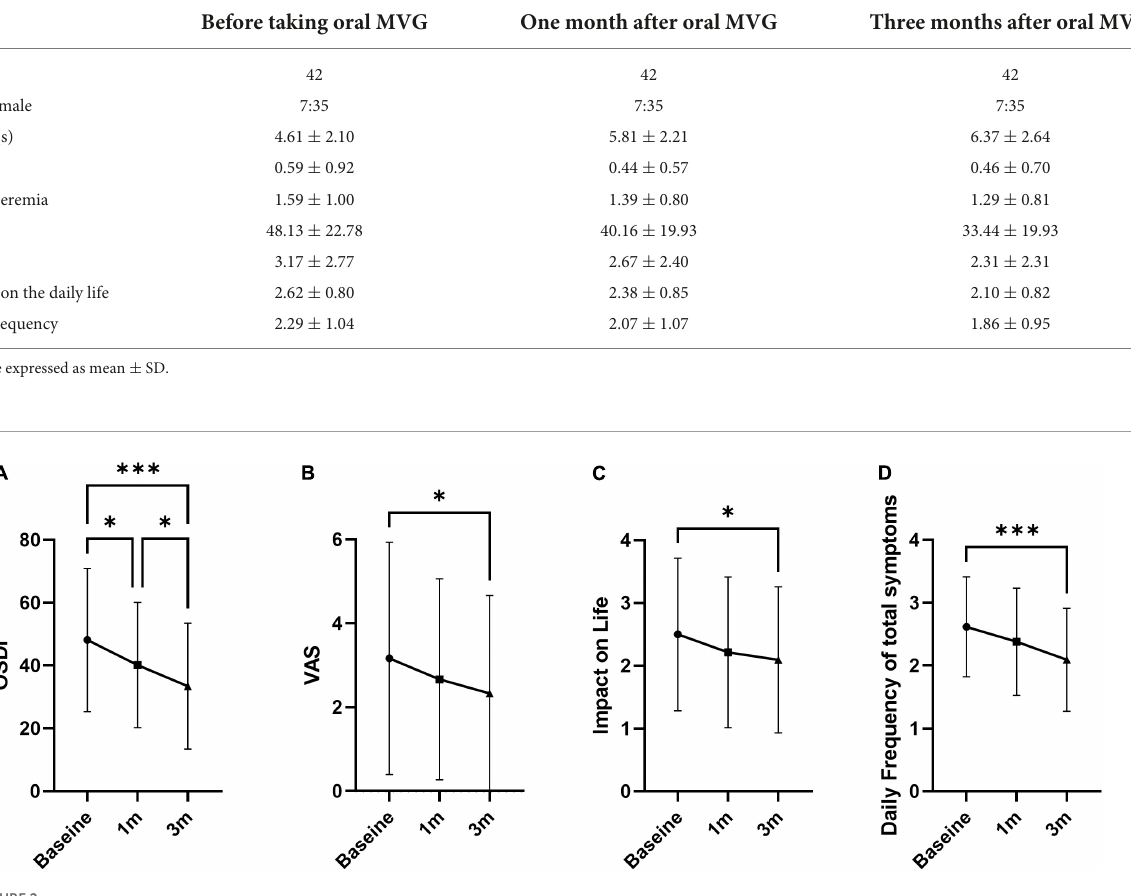
FIGURE2 Overall symptoms of dry eye. (A) Ocular surface disease index. (B) Visual analog pain score. (C) Impact of symptoms on daily life. (D) Daily frequency of total symptoms. Data presented as mean ± SD. ∗ p < 0.05, ∗∗ p < 0.01, and ∗∗∗ p <